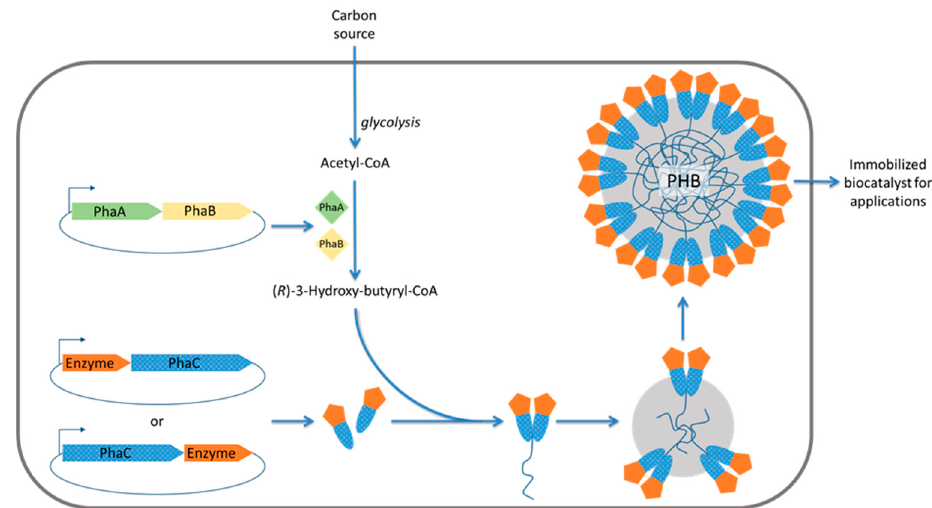
Figure 3. Schematic outlining in situ formation of polyhydroxyalkanoate (PHA) inclusions displaying enzymes. PhaA, β -ketothiolase; PhaB, acetoacetyl-CoA reductase; PhaC, PHA synthase; PHB, polyhydroxybutyrate.